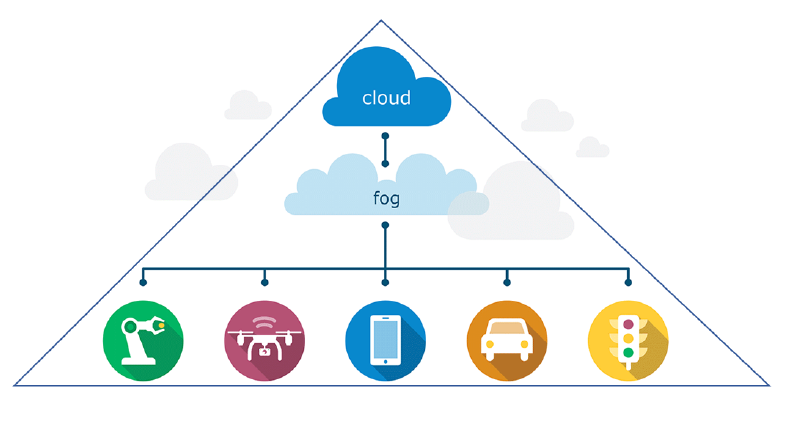
Figure 9. The FC